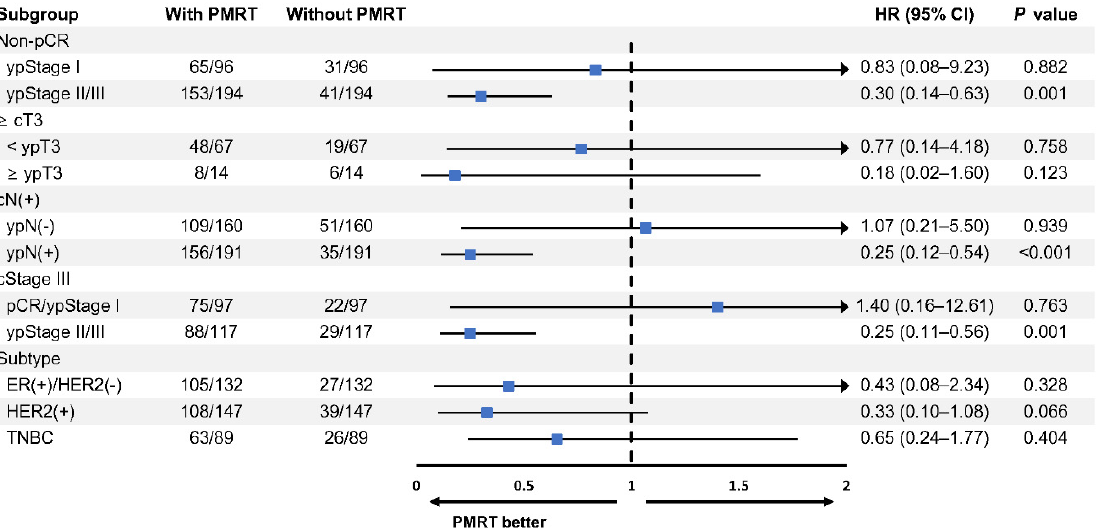
Figure 4. Subgroup analysis of OS according to PMRT status in 1:3 PSM patients. OS, overall survival; PSM, propensity score matching; PMRT, post-mastectomy radiotherapy; HR, hazard ratio; CI, confidence interval; pCR, pathologic complete response; ER, estrogen receptor; HER2, human epidermal growth factor receptor 2; TNBC, triple-negative breast cancer.